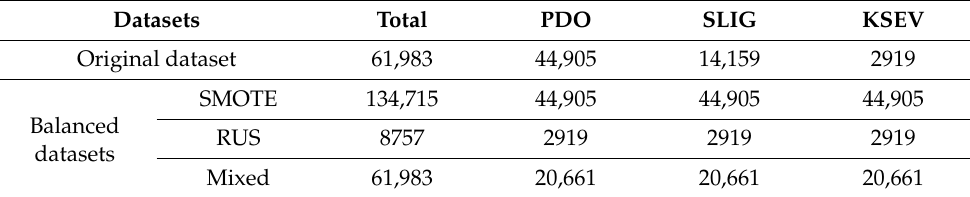
Table 3. Number of Instances in Original and Balanced Training Datasets.